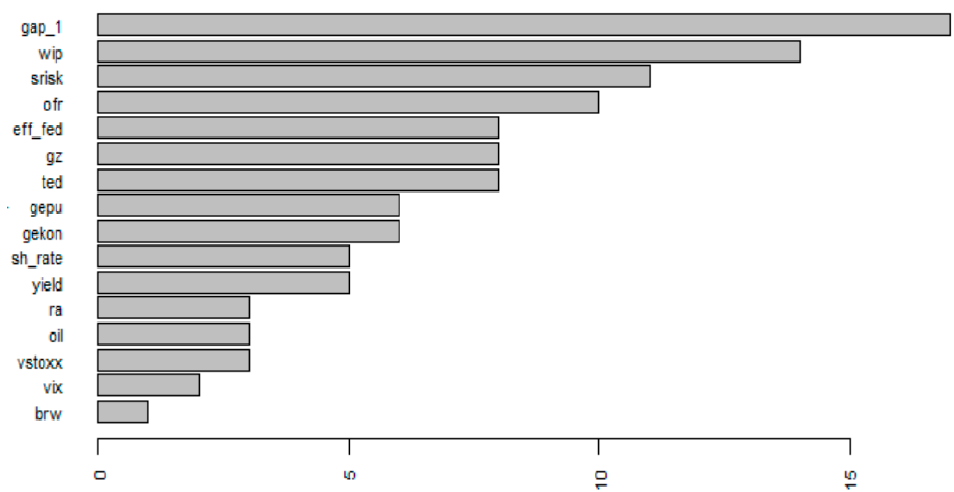
Figure 2. Variable importance ranking for 2007Q3:2013Q4.